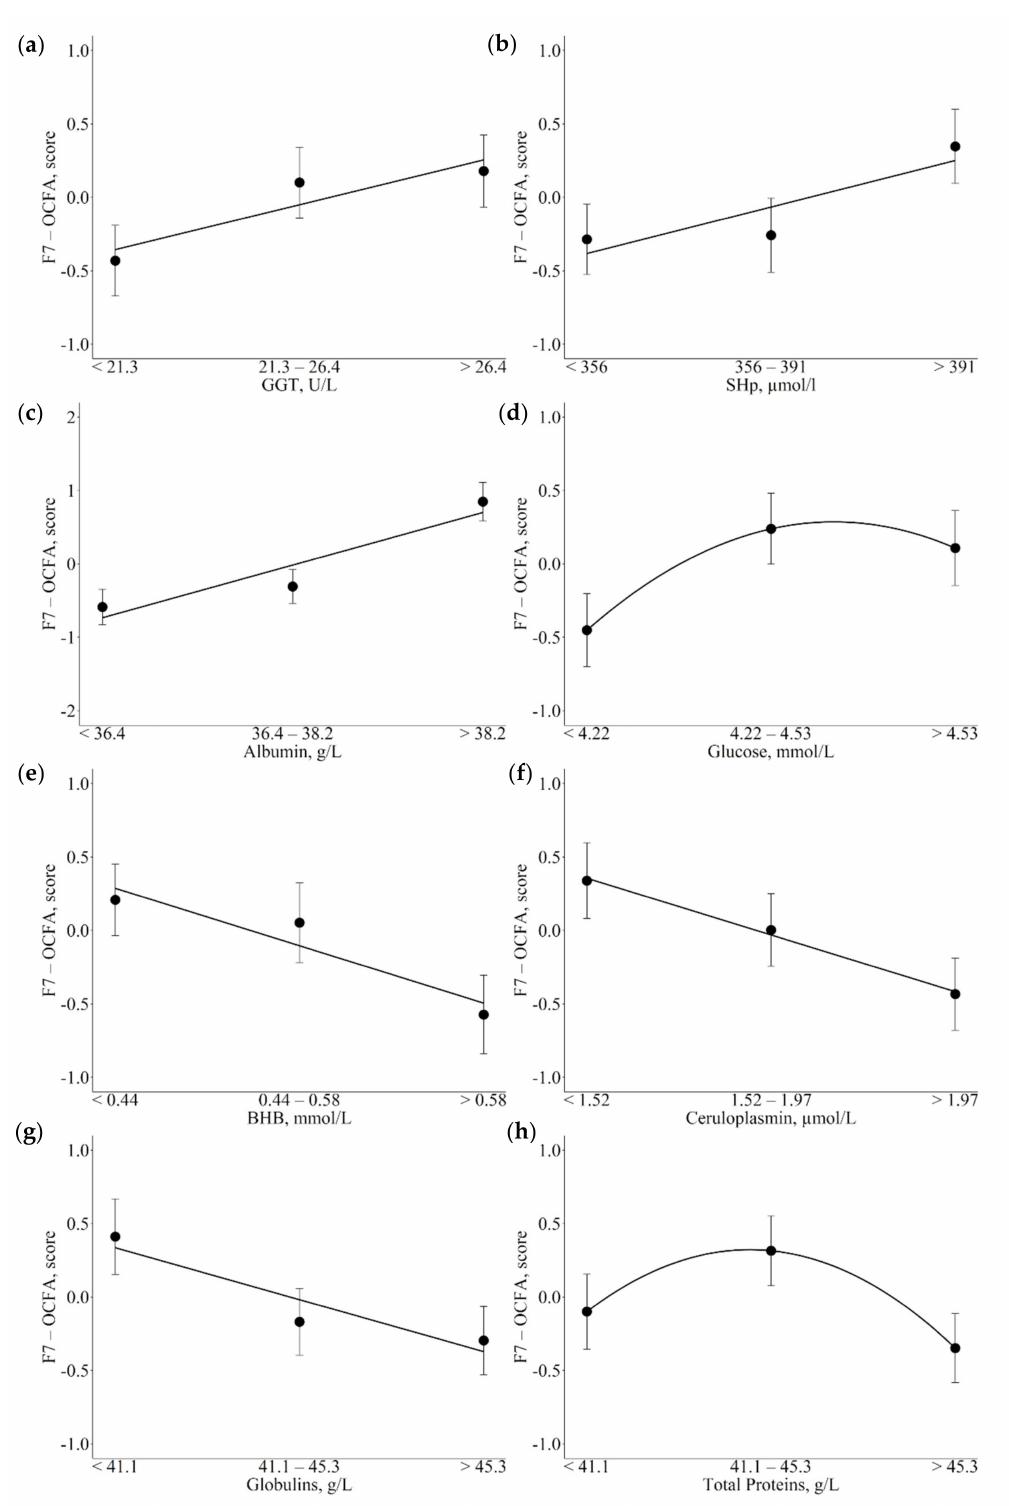
Figure 4. Least square means (LSM) for F7-odd chain fatty acids (OCFA) across the traits of con- cern. ( a ): = γ -glutamyl transferase (GGT); ( b ): total thiol groups (SHp); ( c ): albumin; ( d ): glucose; ( e ): β -hydroxybutyrate acid (BHB); ( f ): ceruloplasmin; ( g ): globulins; ( h ): total proteins. Black dots indicate the LSM and error bars indicate the standard error. Trendlines define linear or quadratic pattern according to polynomial contrast calculations ( p <